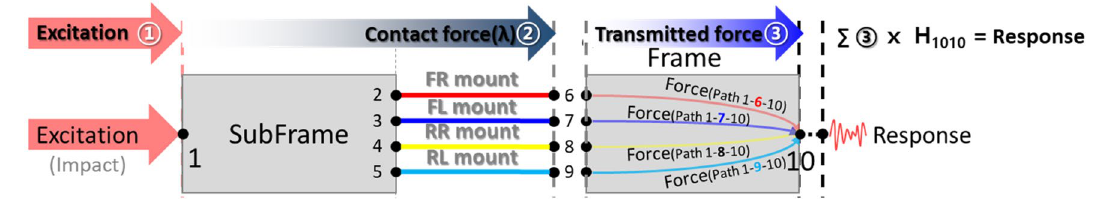
Figure 4. Schematic diagram of the power transmission process.